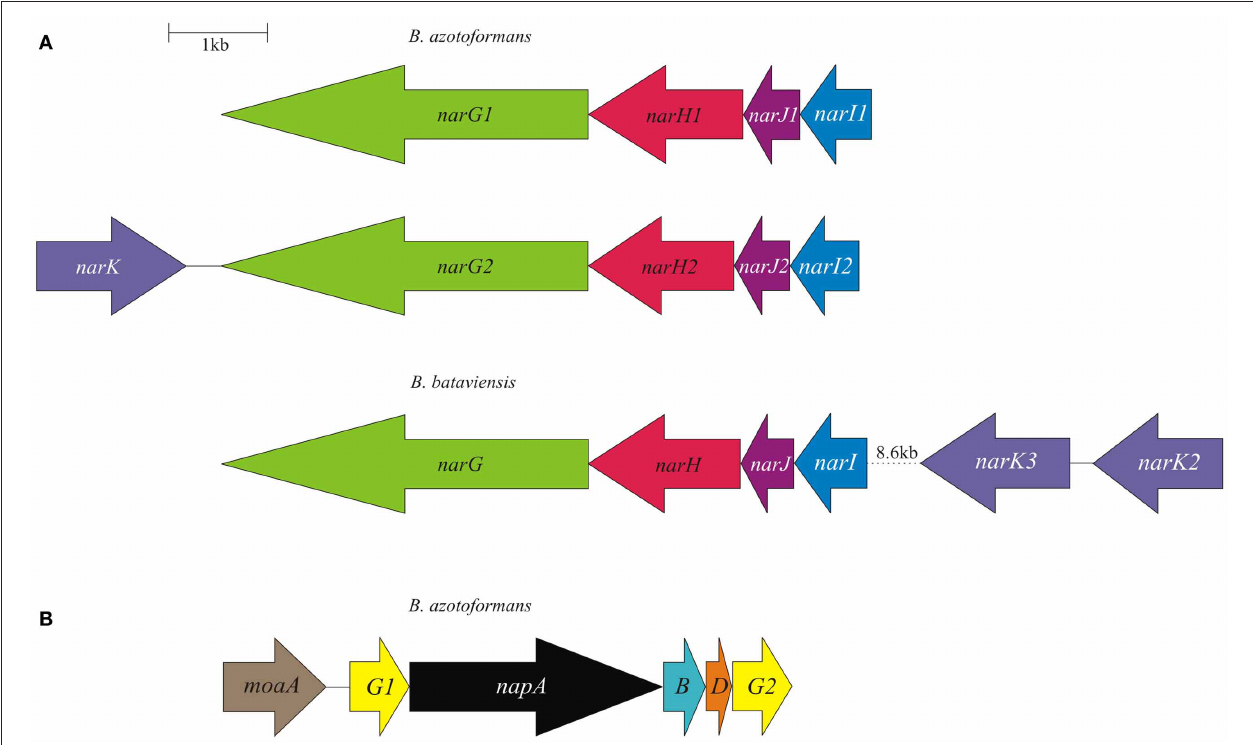
FIGURE 1 | Physical map of the B. azotoformans LMG 9581 T and B. bataviensis LMG 21833 T nar (A) and nap (B) gene clusters. Arrows show the direction of transcription. Open reading frames are drawn to scale. Homologousgenes are shown in identical